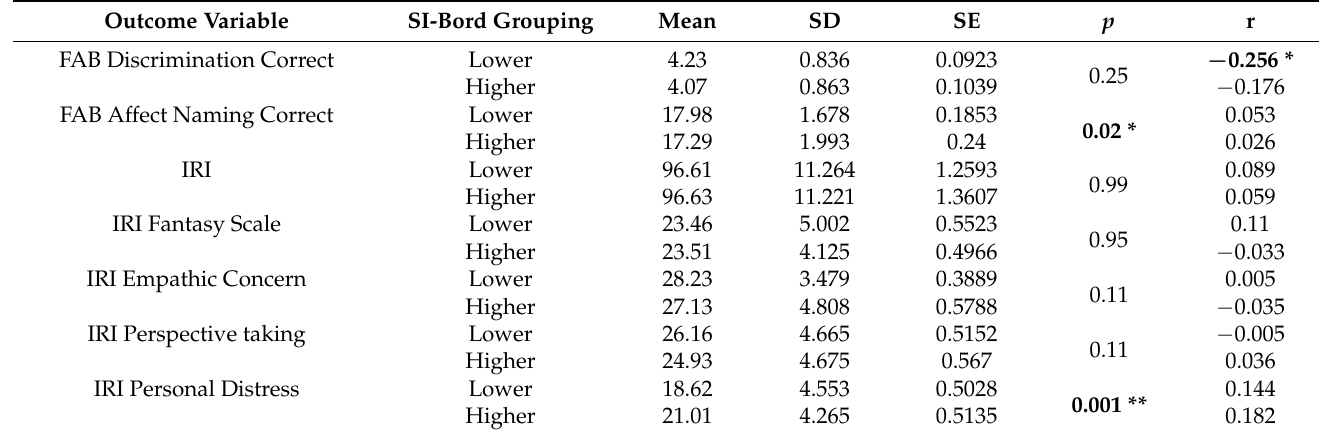
Table 3. Descriptive statistics for the SI-Bord scorers on measures of social cognition and empathy stratified by lower SI-Bord ( n = 82) and higher SI-Bord ( n = 69) scorers. Outcome Variable SI-Bord Grouping Mean SD SE p